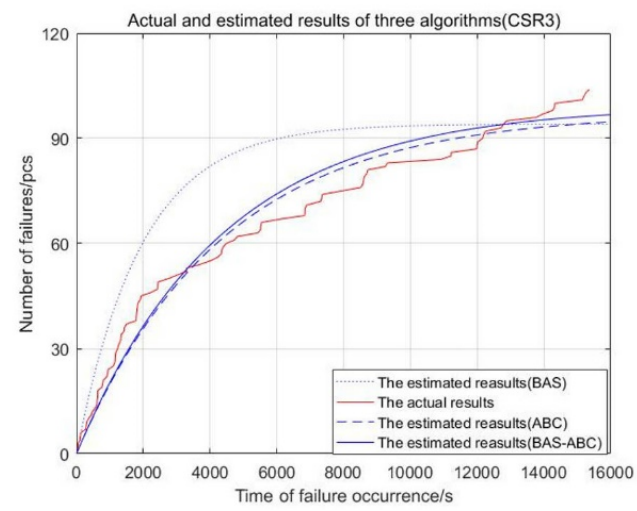
Figure 6. Actual and estimated time of failure occurrence of three algorithms (CSR2).